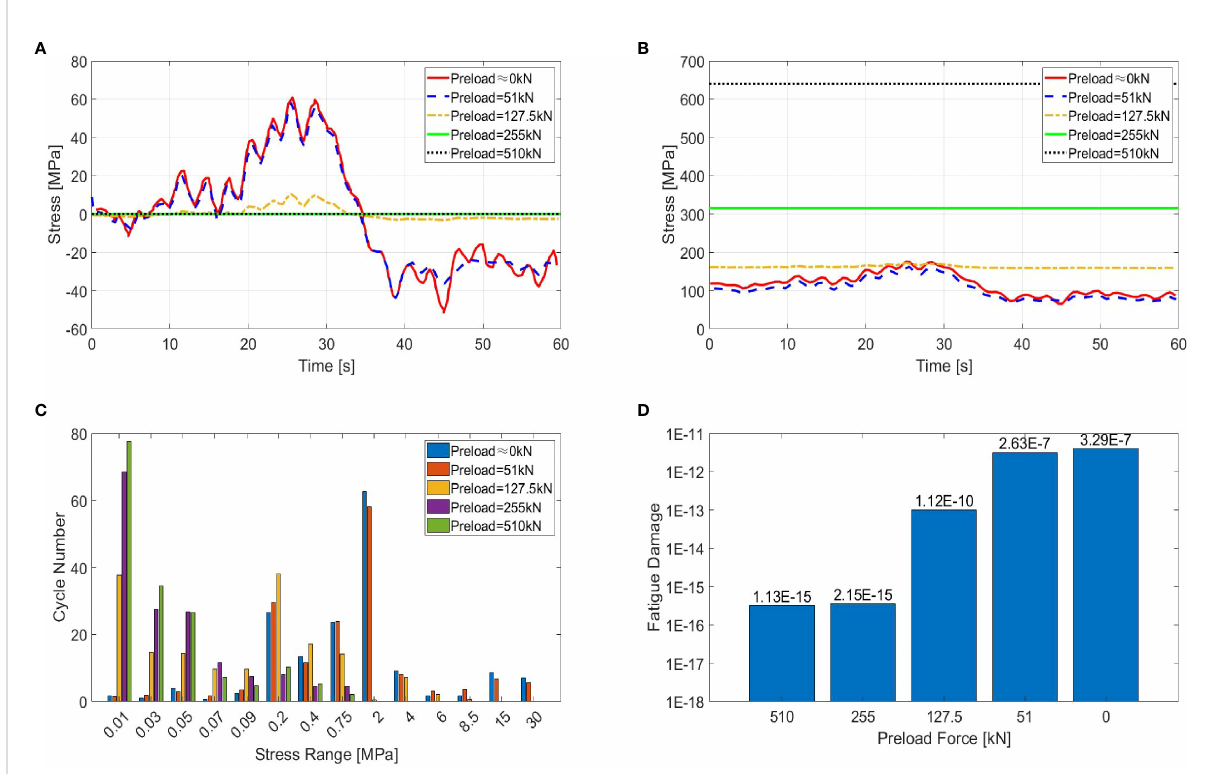
FIGURE 10 (A) Time series of bolt stress with averages removed under different preloads; (B) Time series of bolt stress under different preloads; (C) stress range histograms; (D) fatigue damage under different preloads for one minute loading (Badrkhani Ajaei and Soyoz,